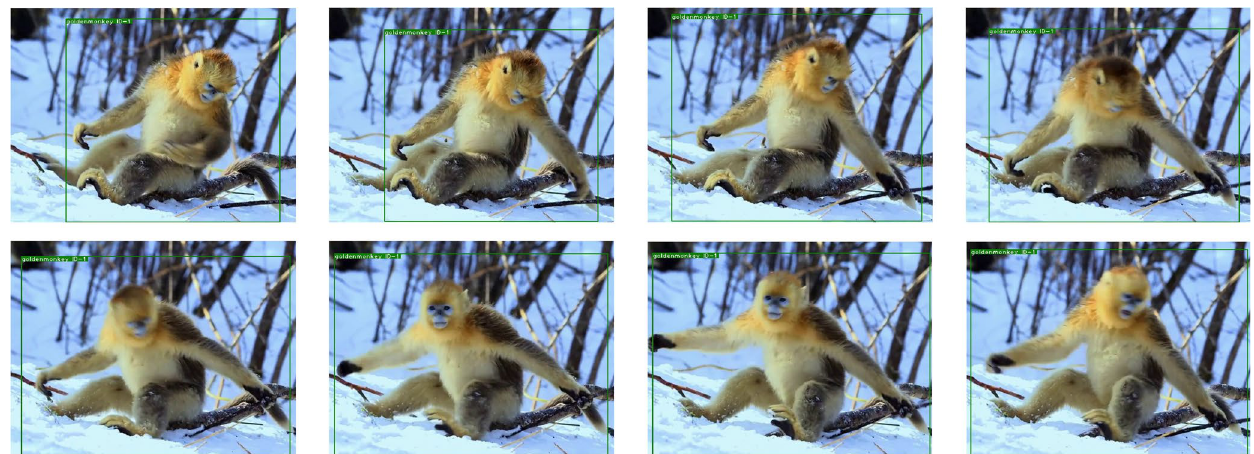
Figure 9. Tracking example of a golden snub-nosed